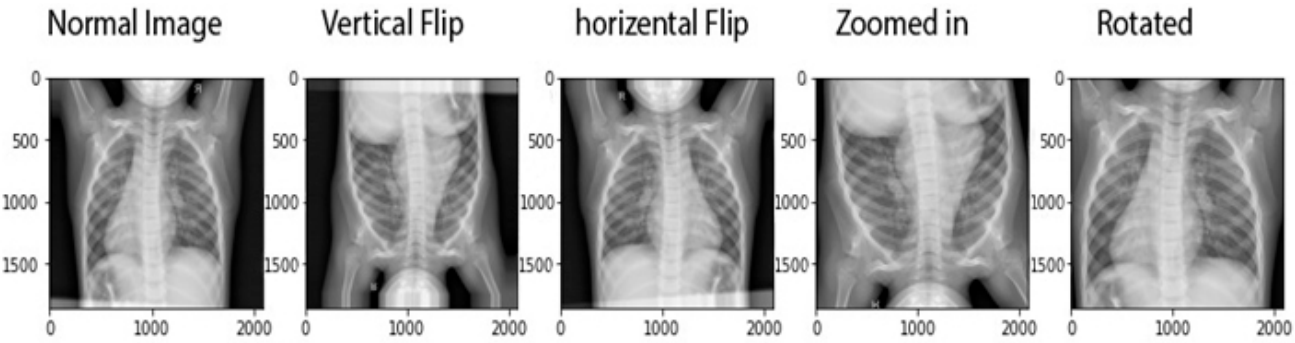
Figure 4. Augmentation techniques applied on input images used in this study [33] .